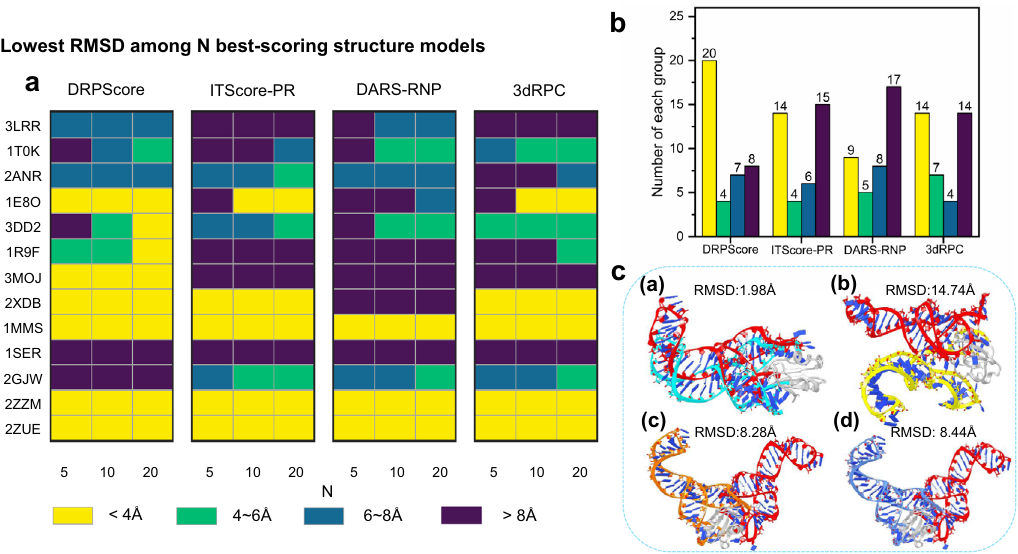
Fig. 3 | Detailed analysis of native-like structures ranking in the unbound- bound testing set. a The N best-scoring structural models for each unbound- bound docking RNA-protein complex for DRPScore, ITScore-PR, DARS-RNP, and 3dRPC in the top 5,10, and 20 predictions. The RNA-protein complexes are sorted (top to bottom) by the number of nucleotides/residues at the RNA-protein inter- action interface. For each scoring function, RNA, and value of N, the lowest RMSD (Root Mean Square Deviation) across structural decoys is recorded. These results